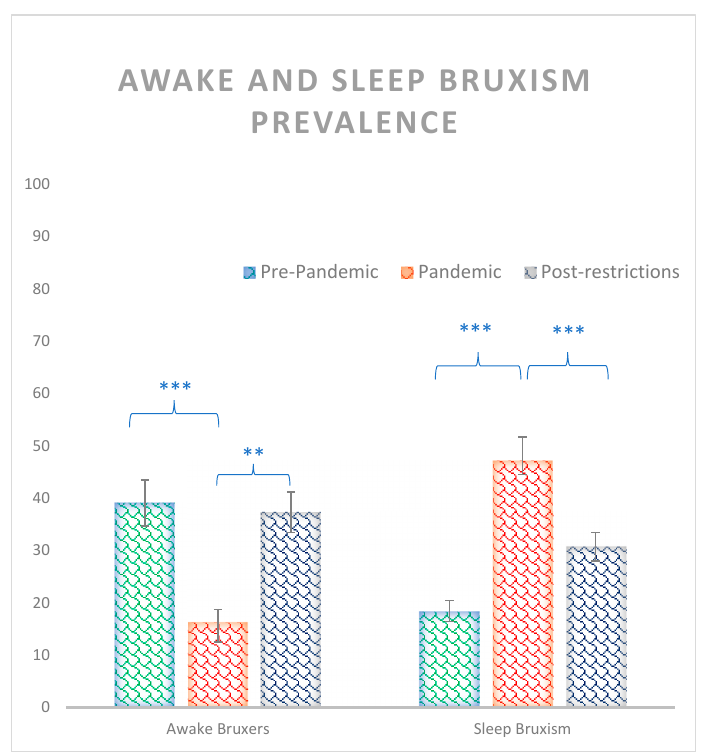
Figure 1. Percentage of awake and sleep bruxism prevalence for pre-pandemic, pandemic, and post restrictions groups. Where *** = p < 0.001, ** = p < 0.01. Bars indicate error rates.